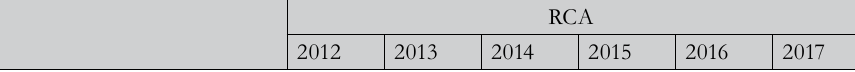
Tab. 1 – Comparative advantages of Ukraine in foreign trade in separate groups of